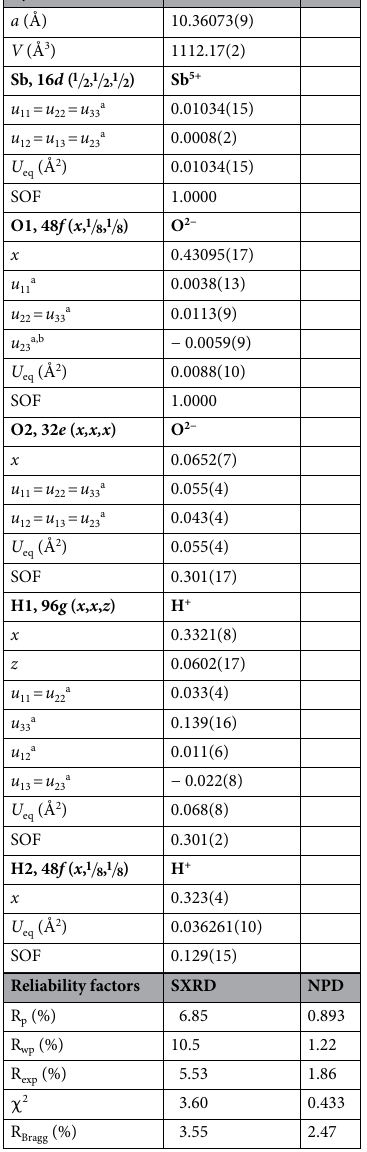
Table 1. Structural parameters for AA refined from combined SXRD and NPD data. Unit-cell ( a ), fractional atomic coordinates ( x , z ), Debye–Waller anisotropic ( u ij ) and equivalent isotropic ( U eq ) displacement factors, SOFs and Rietveld agreement factors (R p , R wp , R exp , χ 2 , and R Bragg ) for (H 3 O) 1.20(7) H 0.77(9) Sb 2 O 6 , with cubic space group Fd 3 m ( # 227) and Z = 8, from dual SXRD and NPD data refinement collected at 298